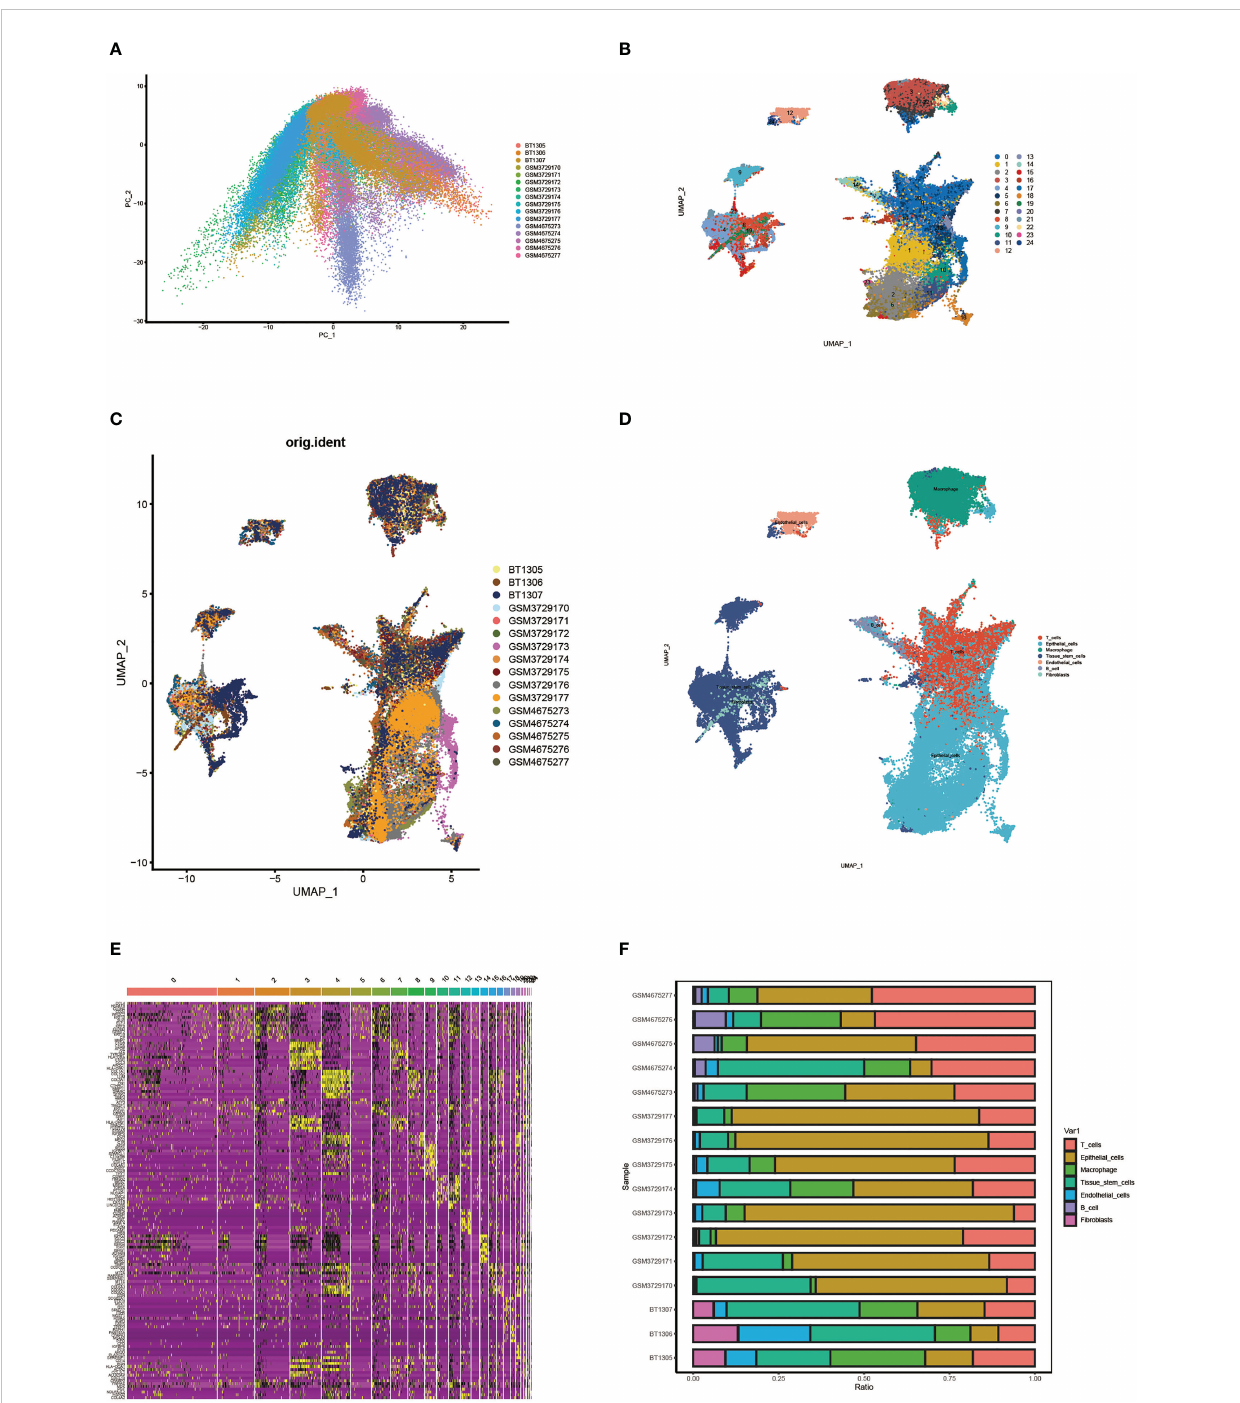
FIGURE 2 Single cell cluster analysis in patients with ovarian cancer. (A) Single cell data were subjected to PCA dimensionality reduction analysis and the fi rst 50 PC principal components were selected for subsequent analysis. (B) Umap plots show 25 clusters of cells generated by clustering after dimension reduction. (C) Umap plot showing cell distribution for different samples. (D) Umap plots show the distribution of cells in each cluster after annotation. (E) Heat map of signature gene expression in different groups. (F) Histograms show the proportion of in fi ltrates per cluster of cells in each